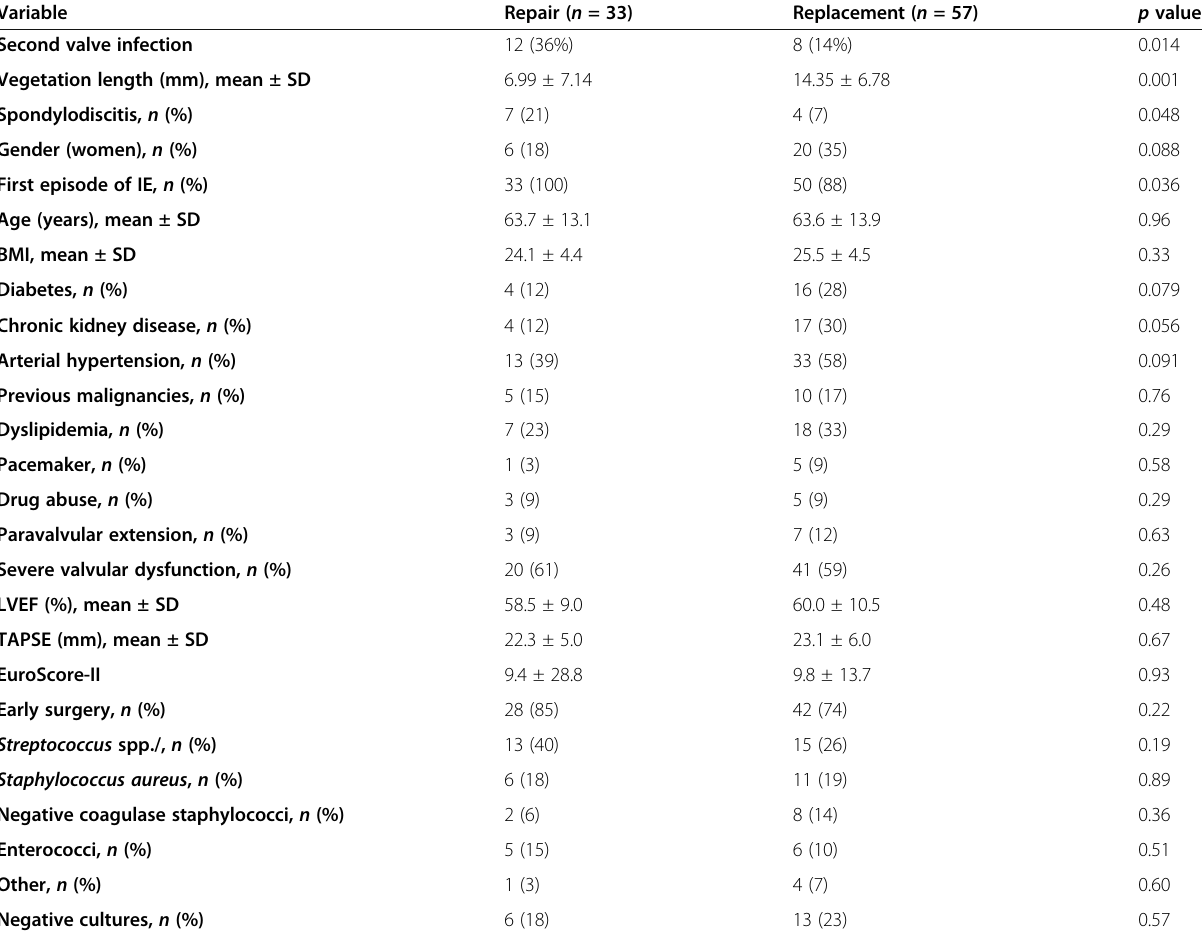
Table 3 Demographic, clinical, echocardiographic, and microbiological characteristics in 90 surgical patients affected by IE on native mitral valve treated with valve repair or